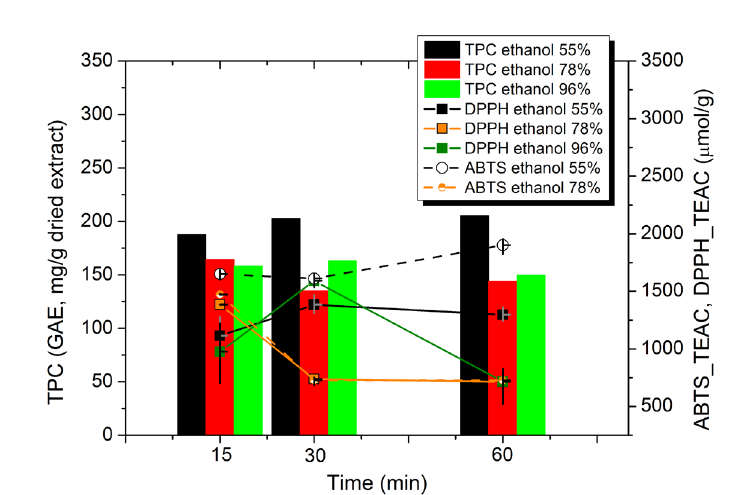
Figure 7. The influence of time on: a) the total polyphenolic content expressed as gallic acid equivalents (GAE, mg g -1 dried extract) vs. ethanol 55%, 78% and 96%; b) antioxidant capacity of the 55% and 78% ethanol extracts expressed as Trolox equivalents (TEAC, µ mol g -1 ) vs. ABTS and DPPH assays; Temperature: 323.15 K, Quantity of plant material: 1